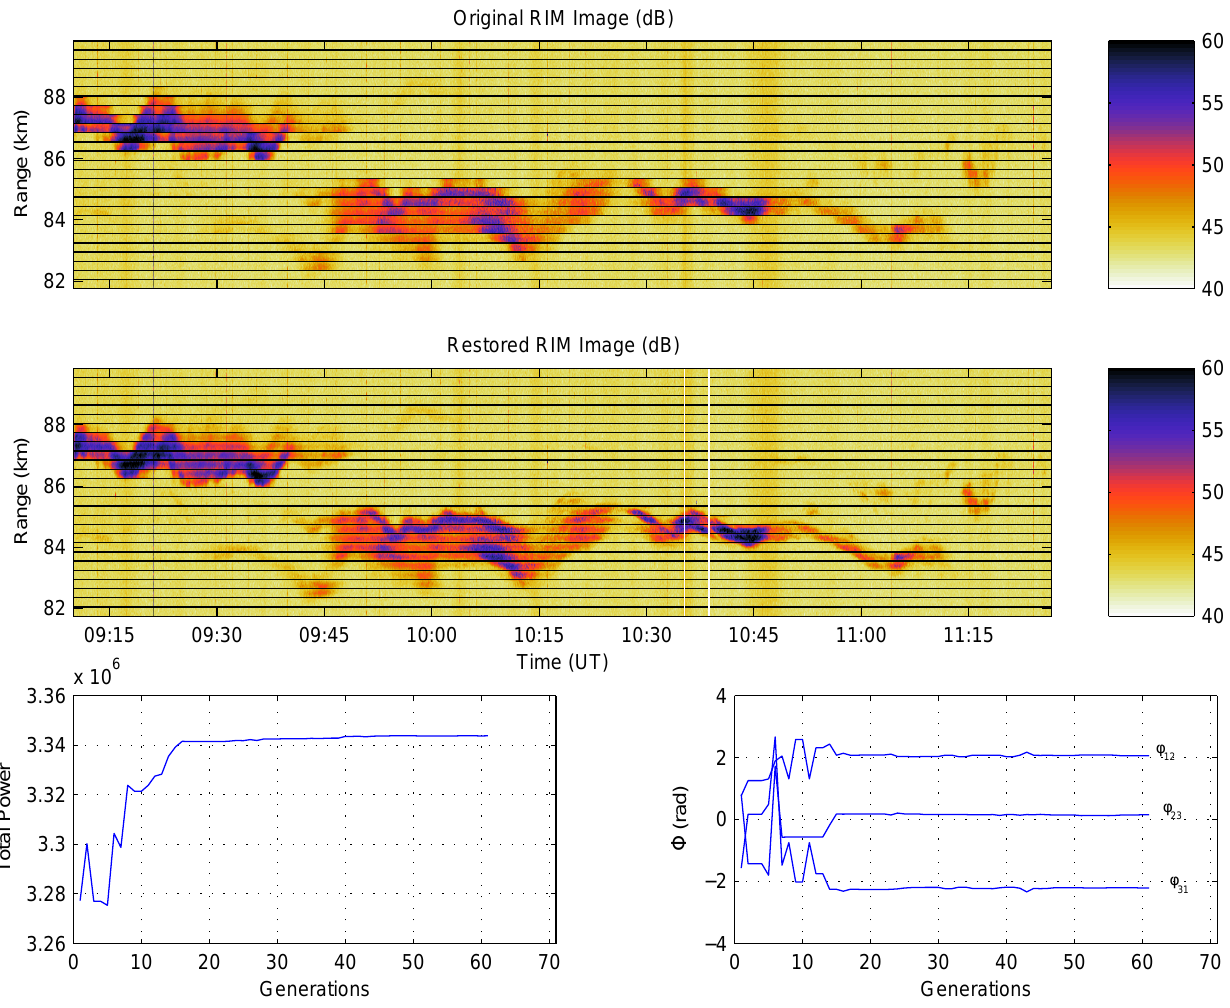
Fig. 9. Comparison of corrupted RIM image and phase-calibrated RIM image. Learning curves and convergence rates are observed in the bottom panels of the